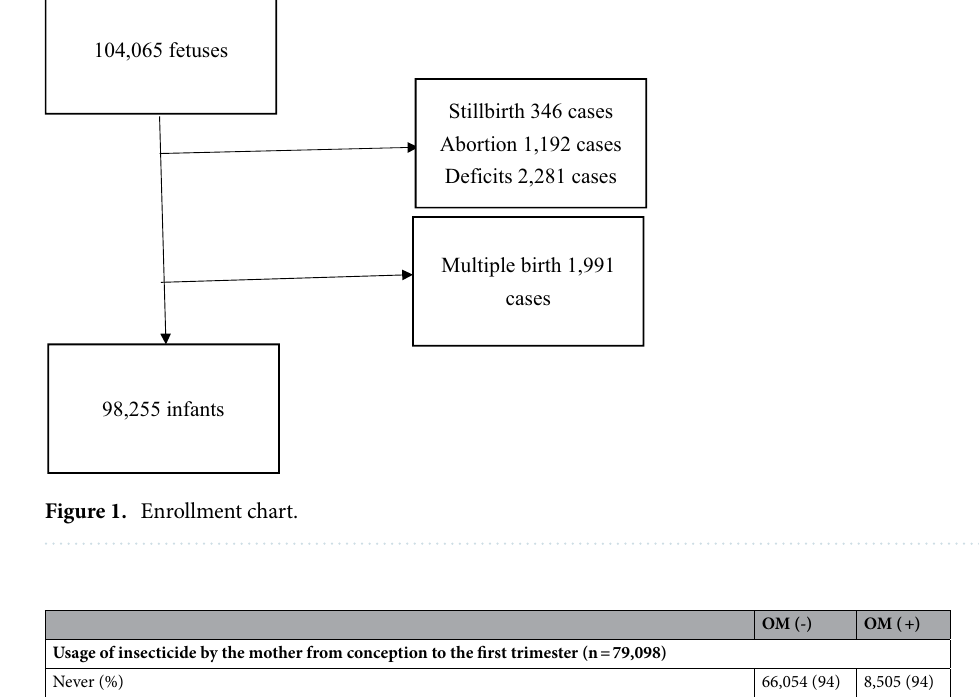
Usage of insecticide by the mother from conception to the first trimester (n = 79,098) Never (%)